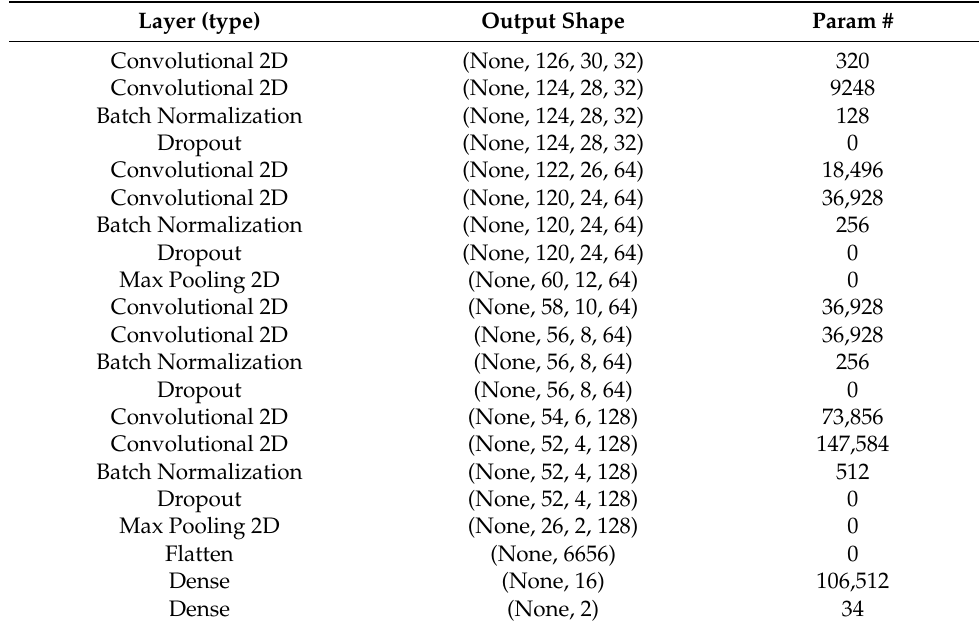
Table A6. Convolutional Neural Networks classifier model architecture.